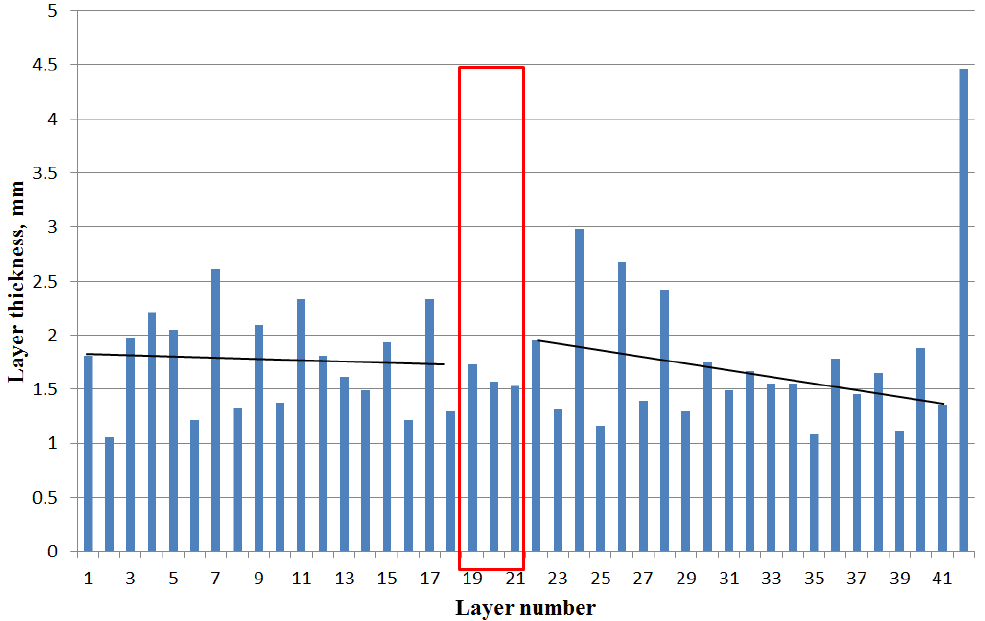
Figure 5. Changes in layer thickness depending on the layer number. The closed red line shows the transition region. Black lines — linear approximation.